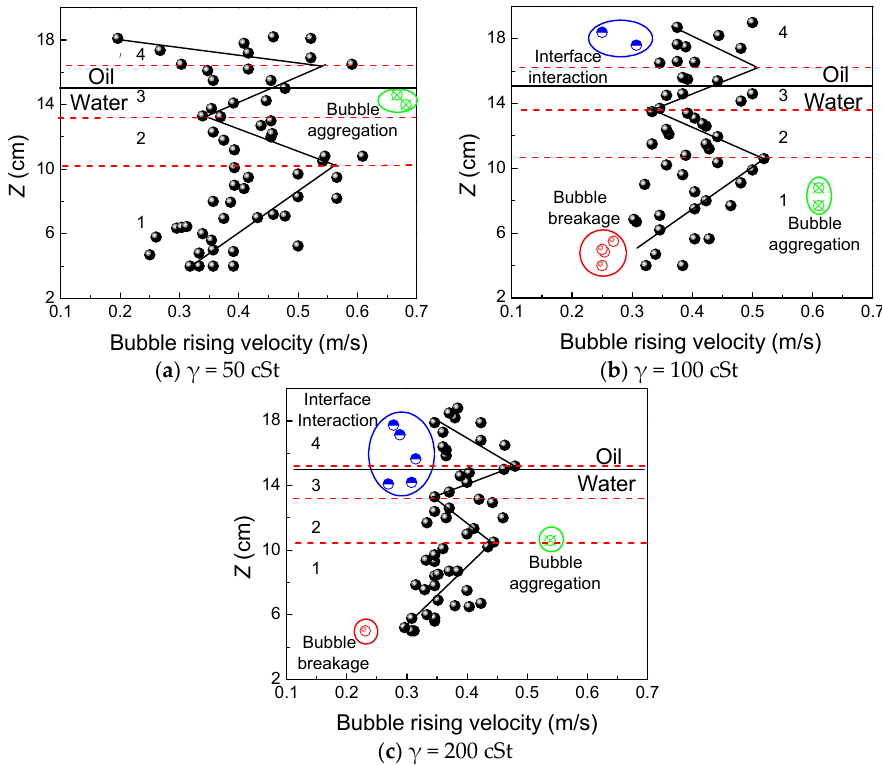
Figure 6. Rising-bubble velocity distribution ( Q = 1000 mL/min).